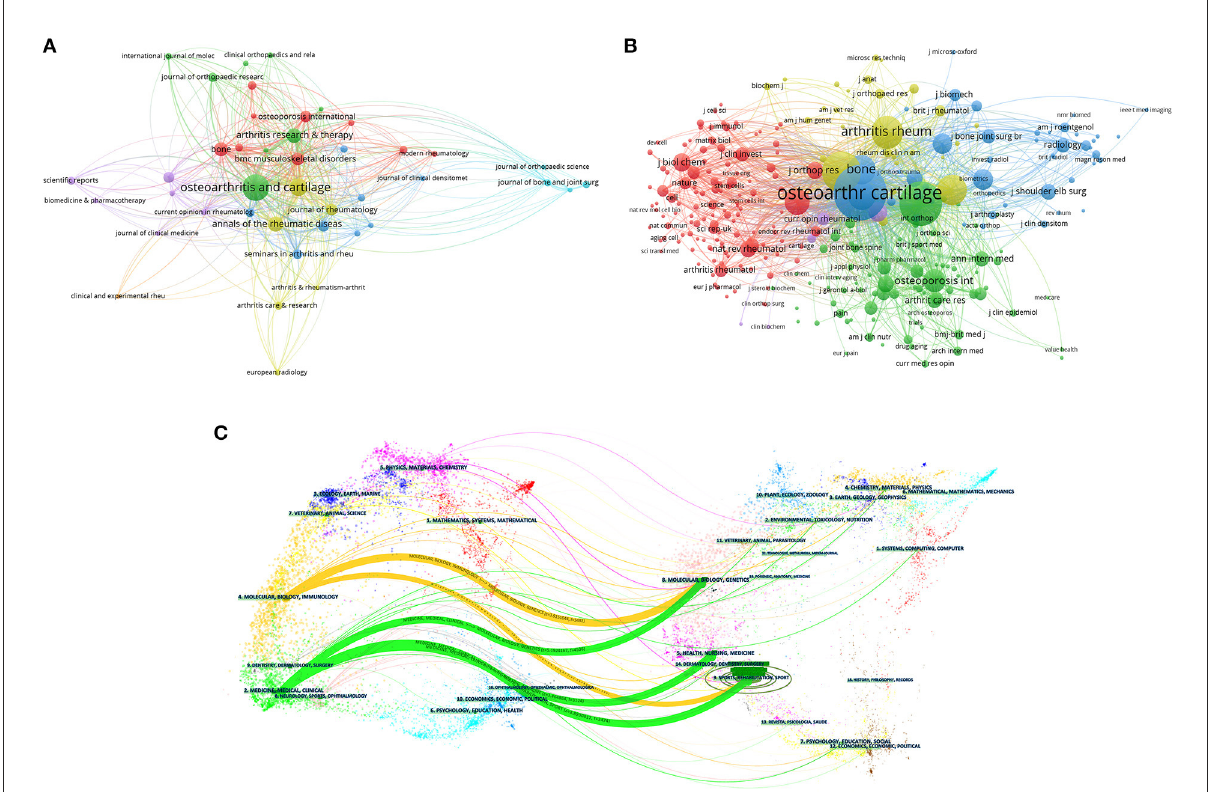
FIGURE7 (A) Visual analysis of co-citation. (B) Clustering network.